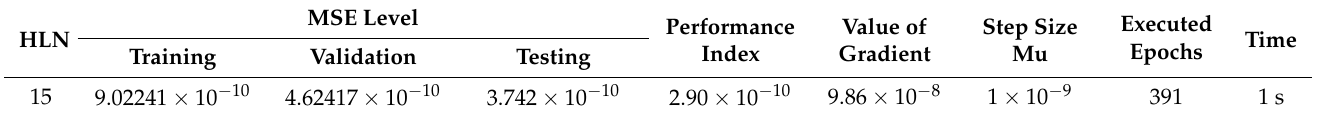
Table 4. ANNLMB outcomes of Scenario 2 for heat transfer in spinning